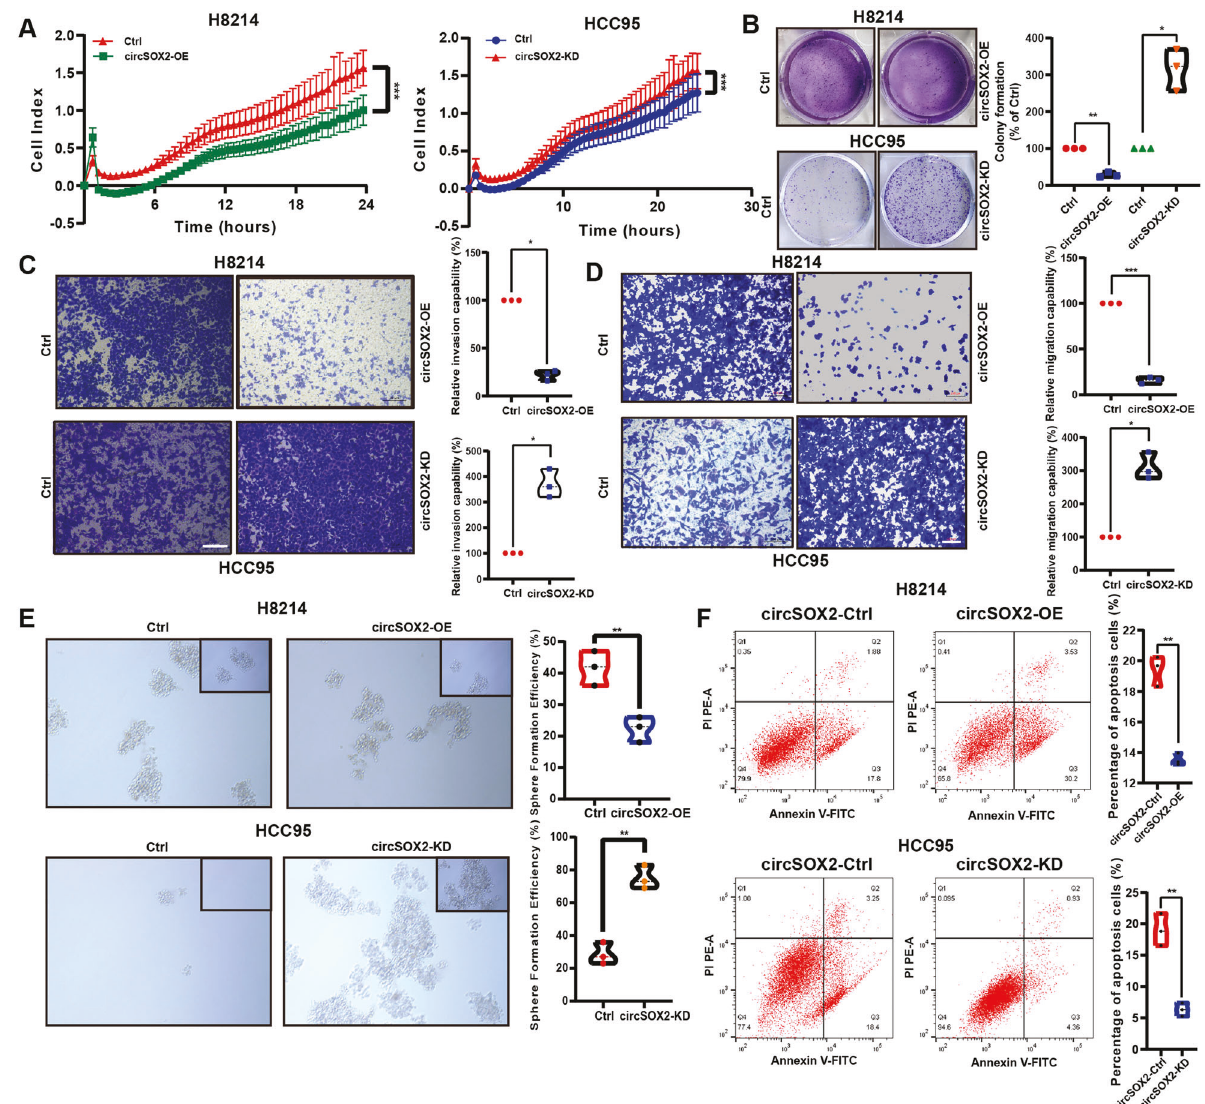
Fig. 2 CircSOX2 suppressed the malignant progression in SOX2-ampli fi ed LUSC cells in vitro. A and B The real-time cell analysis (RTCA) assays revealed that circSOX2 suppressed the proliferation of LUSC cells. C and D Transwell and Matrigel assays indicated that circSOX2 effectively repressed the migration and invasion of LUSC cells. E The sphere-forming assay demonstrated that circSOX2 decreased the width and amount of LUSC sphere cells. F CircSOX2 overexpression suppressed the apoptosis of LUSC cells. *** p < 0.001, ** p < 0.01, * p <